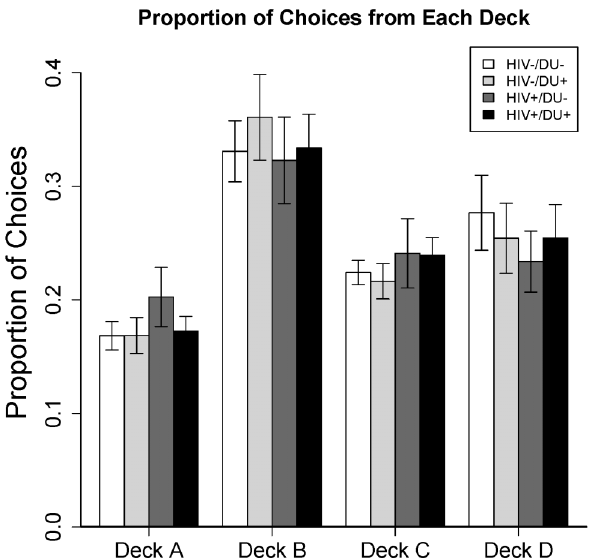
Figure 1. IGT performance (overall proportion of choices from each deck). Error bars indicate ± 1 SEM.